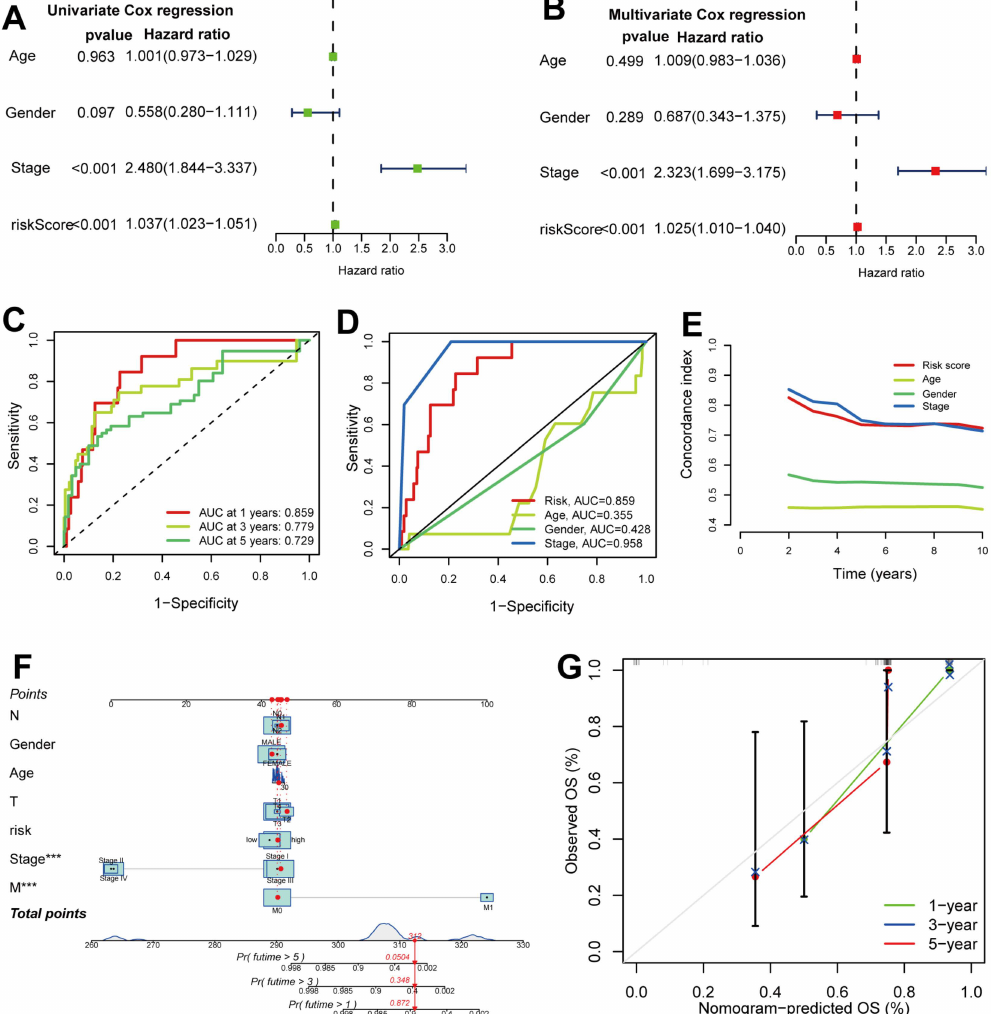
Figure 5. Clinical predictability and independent prognostic ability of five CRLs for patients with pRCC. ( A ) Clinical variables and signature CRLs in a univariate Cox regression. ( B ) A multivariate Cox regression analysis of clinical variables and signature CRLs. ( C ) Prediction 1-, 3- and 5-OS of pRCC patients in the entire set. ( D ) Comparison of predictive risk model and clinicopathological features. ( E ) C-index ROC curve of the risk model. ( F ) A nomogram showing risk and clinicopatho- logical features for predicting 1-, 3- and 5-OS in pRCC patients. ***, p < 0.001. ( G ) Calibration curves indicating the accuracy of risk model to predict 1-, 3- and 5-OS of pRCC